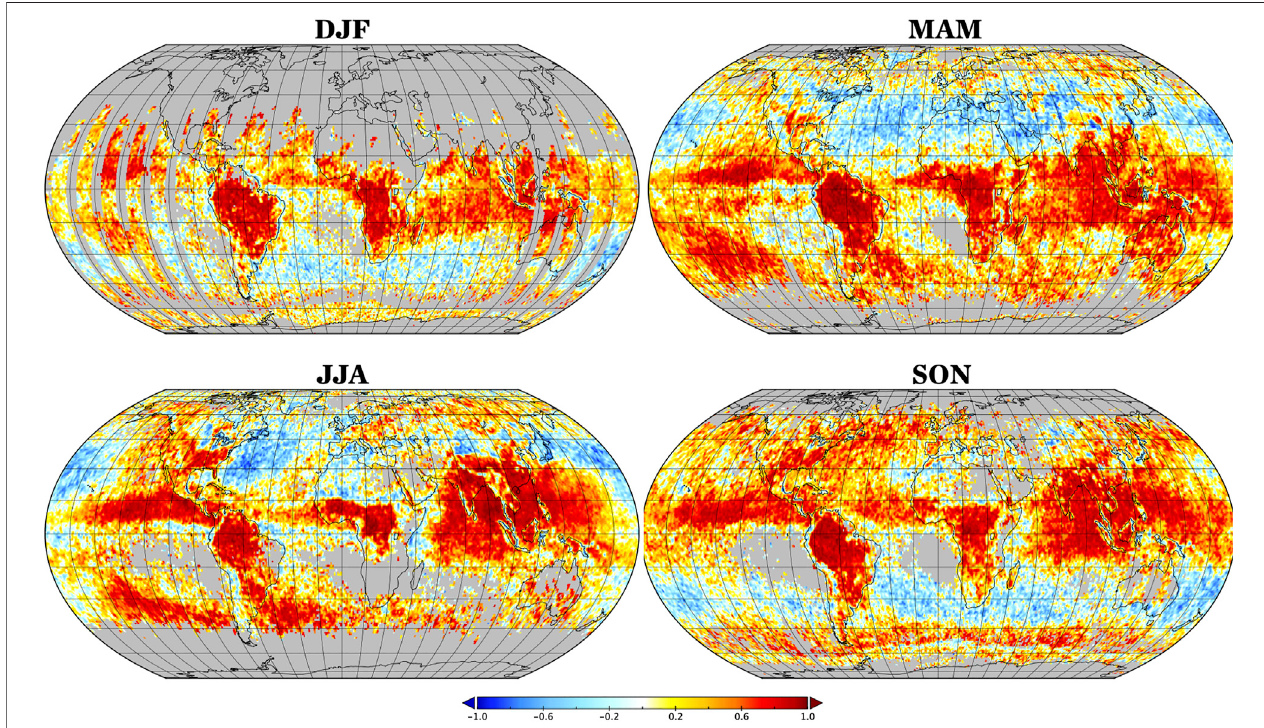
FIGURE 8 | As Figure 7 but for high